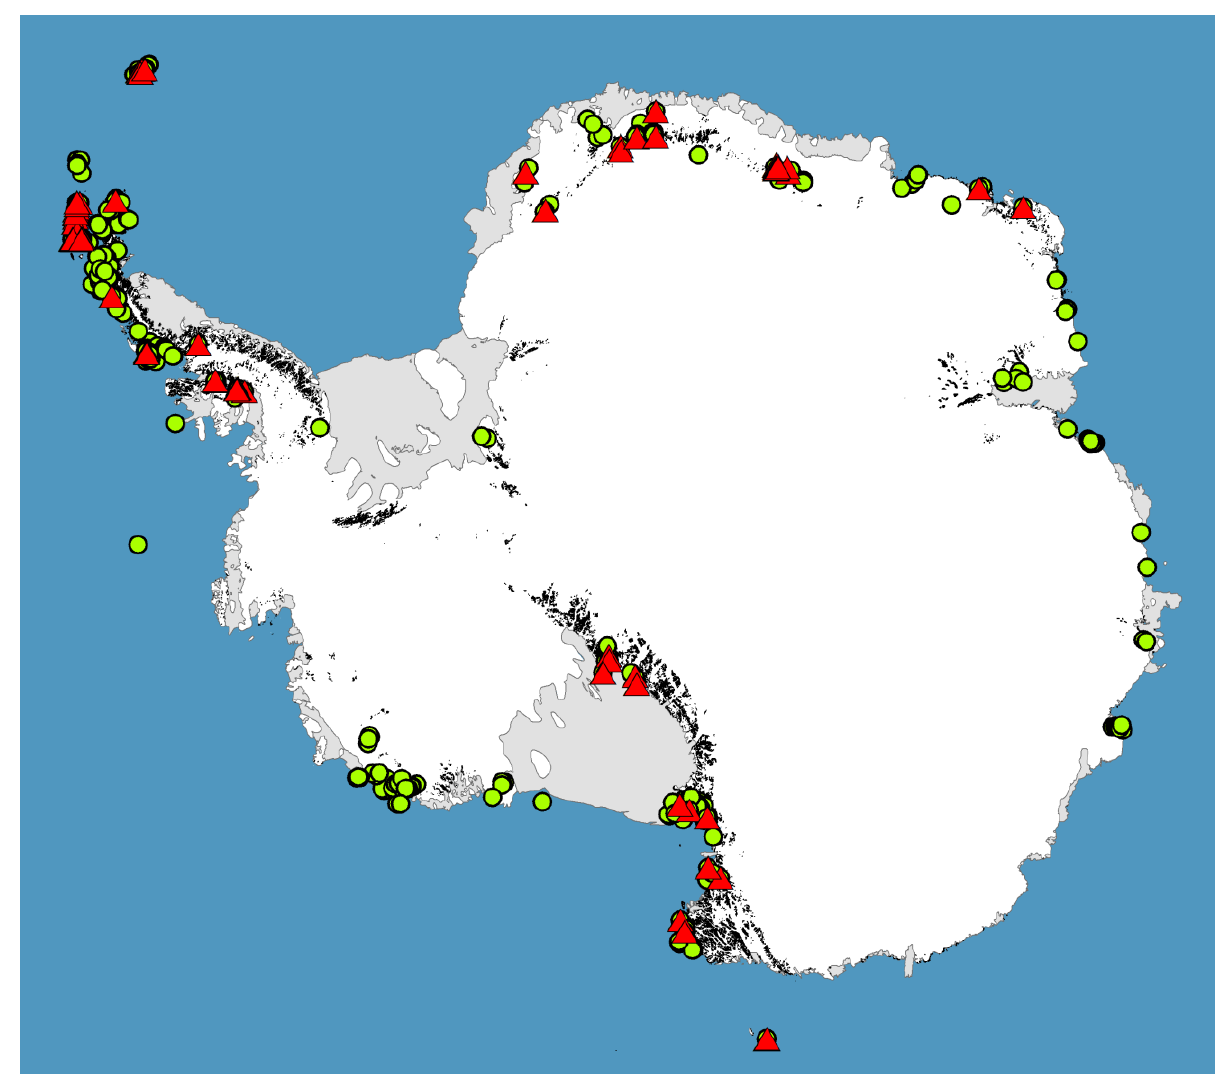
Figure 3. ArcGIS Map of terrestrial invertebrate occurrence records and ice-free terrain [104,105]. Areas shaded in black represent the ice-free terrain where no terrestrial invertebrate collections have been made; red triangles illustrate all springtail records while green circles illustrate all other terrestrial invertebrate